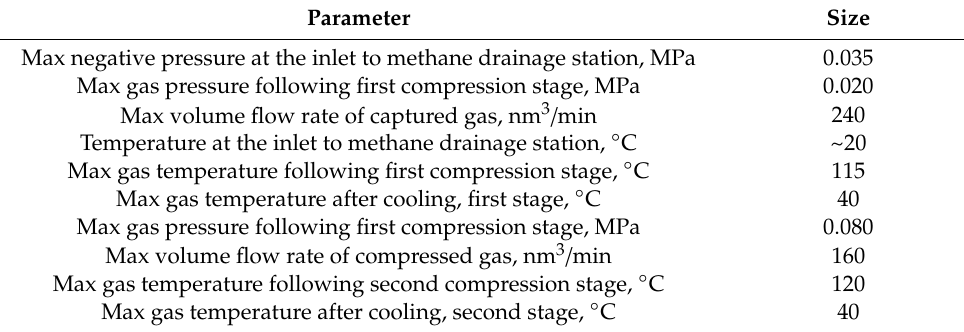
Table 2. Operating parameters of the drainage station located in the Pni ó wek coal